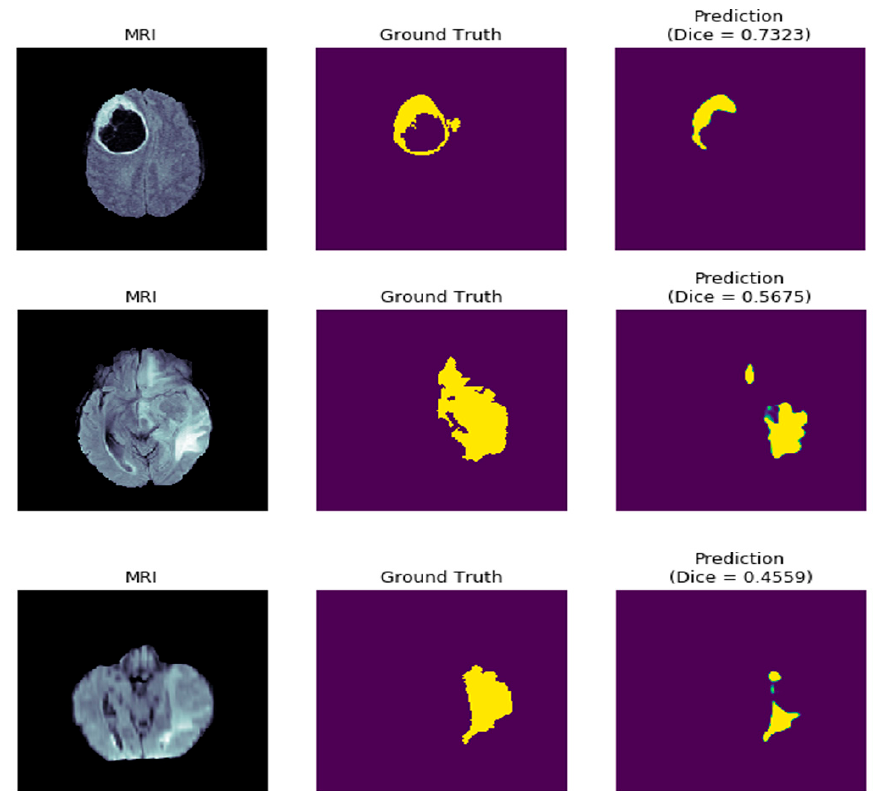
Figure 12. Sample SD-UNet poorly segmented tumors in the test dataset.